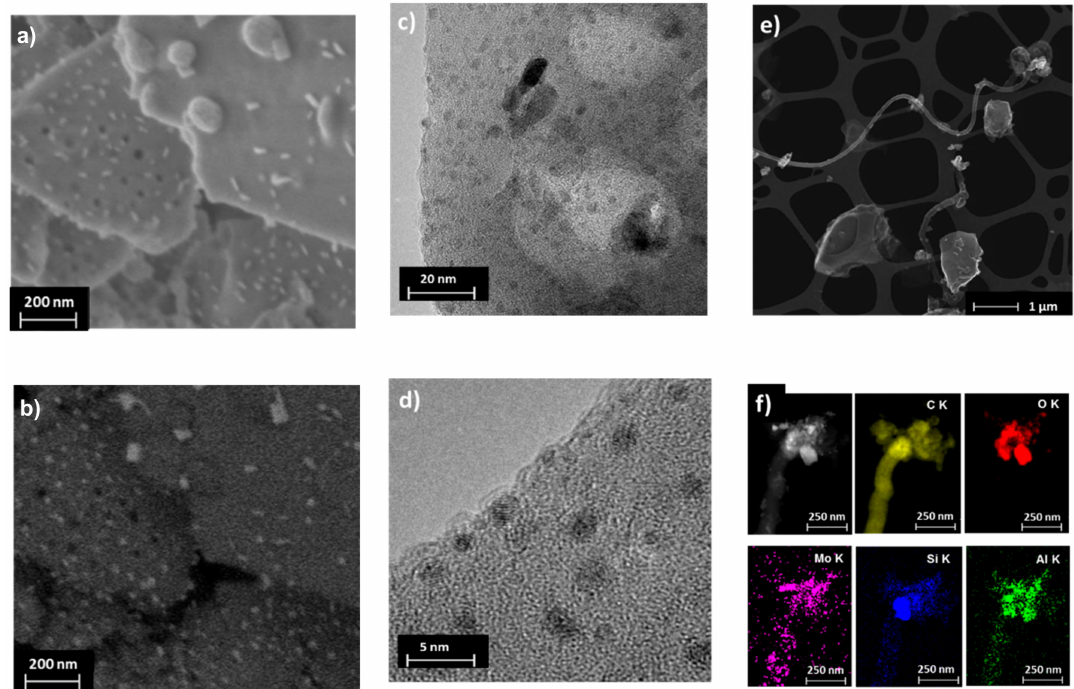
Figure 6. Microscopy images for Mo / H-SSZ-13 after 10 h of reaction. High-resolution SEM secondary ( a ) and backscattered ( b ) electron images; TEM images at two di ff erent magnifications ( c , d ); dark field TEM image of filamentous carbon ( e ); and the TEM-EDX elemental maps of filamentous carbon ( f